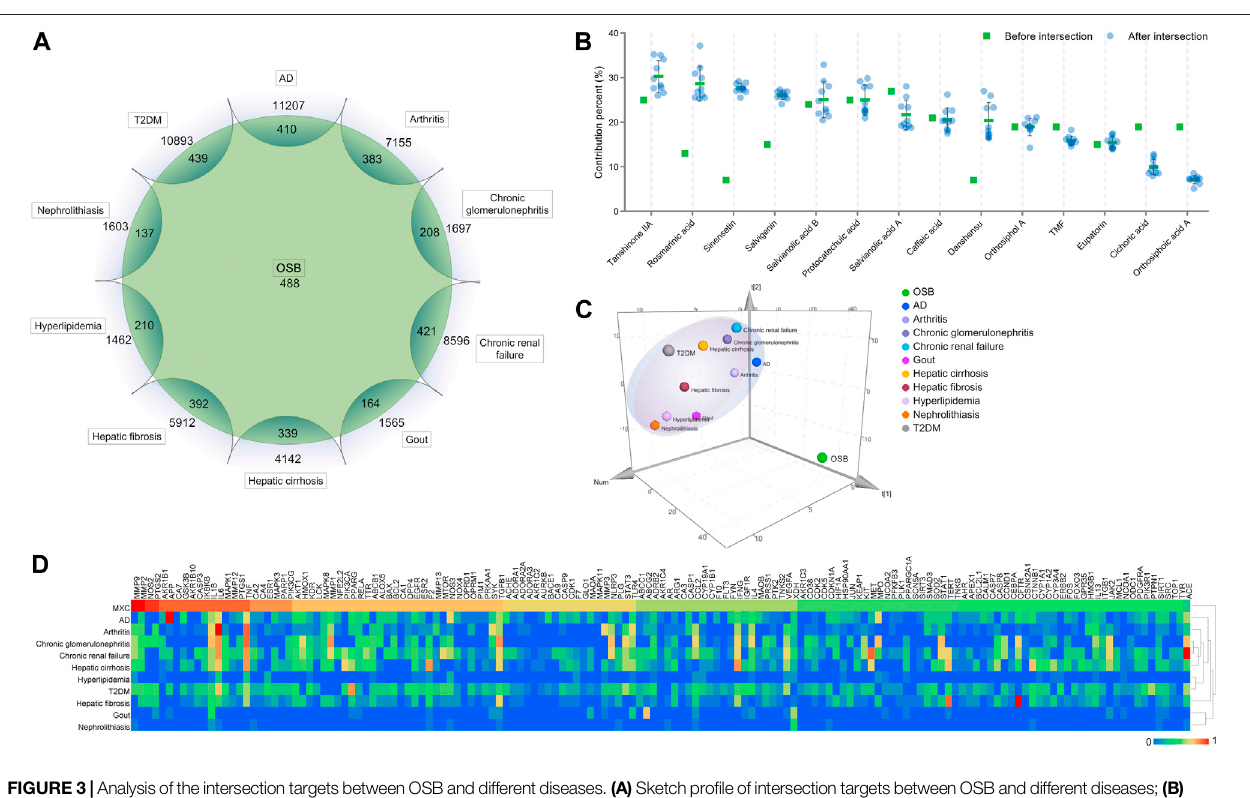
FIGURE 3 | AnalysisoftheintersectiontargetsbetweenOSBanddifferentdiseases. (A) Sketchpro fi leofintersectiontargetsbetweenOSBanddifferentdiseases; (B) Contribution ofeachconstituent tothe intersection targets of all OSB-disease pairs; (C) 3D score plotgeneratedin SIMCA software using the PCA model for visualizing the overall relevanceoftargetsbetweengroups; (D) Heatmapintegrating theHCAmodel for visualizing therelevance ofbothindividual and overalltargetsbetween groups. AD, Alzheimer ’ s disease; HCA, hierarchical cluster analysis; OSB, Orthosiphon stamineus Benth.; PCA, principal component analysis; T2DM, type 2 diabetes mellitus.